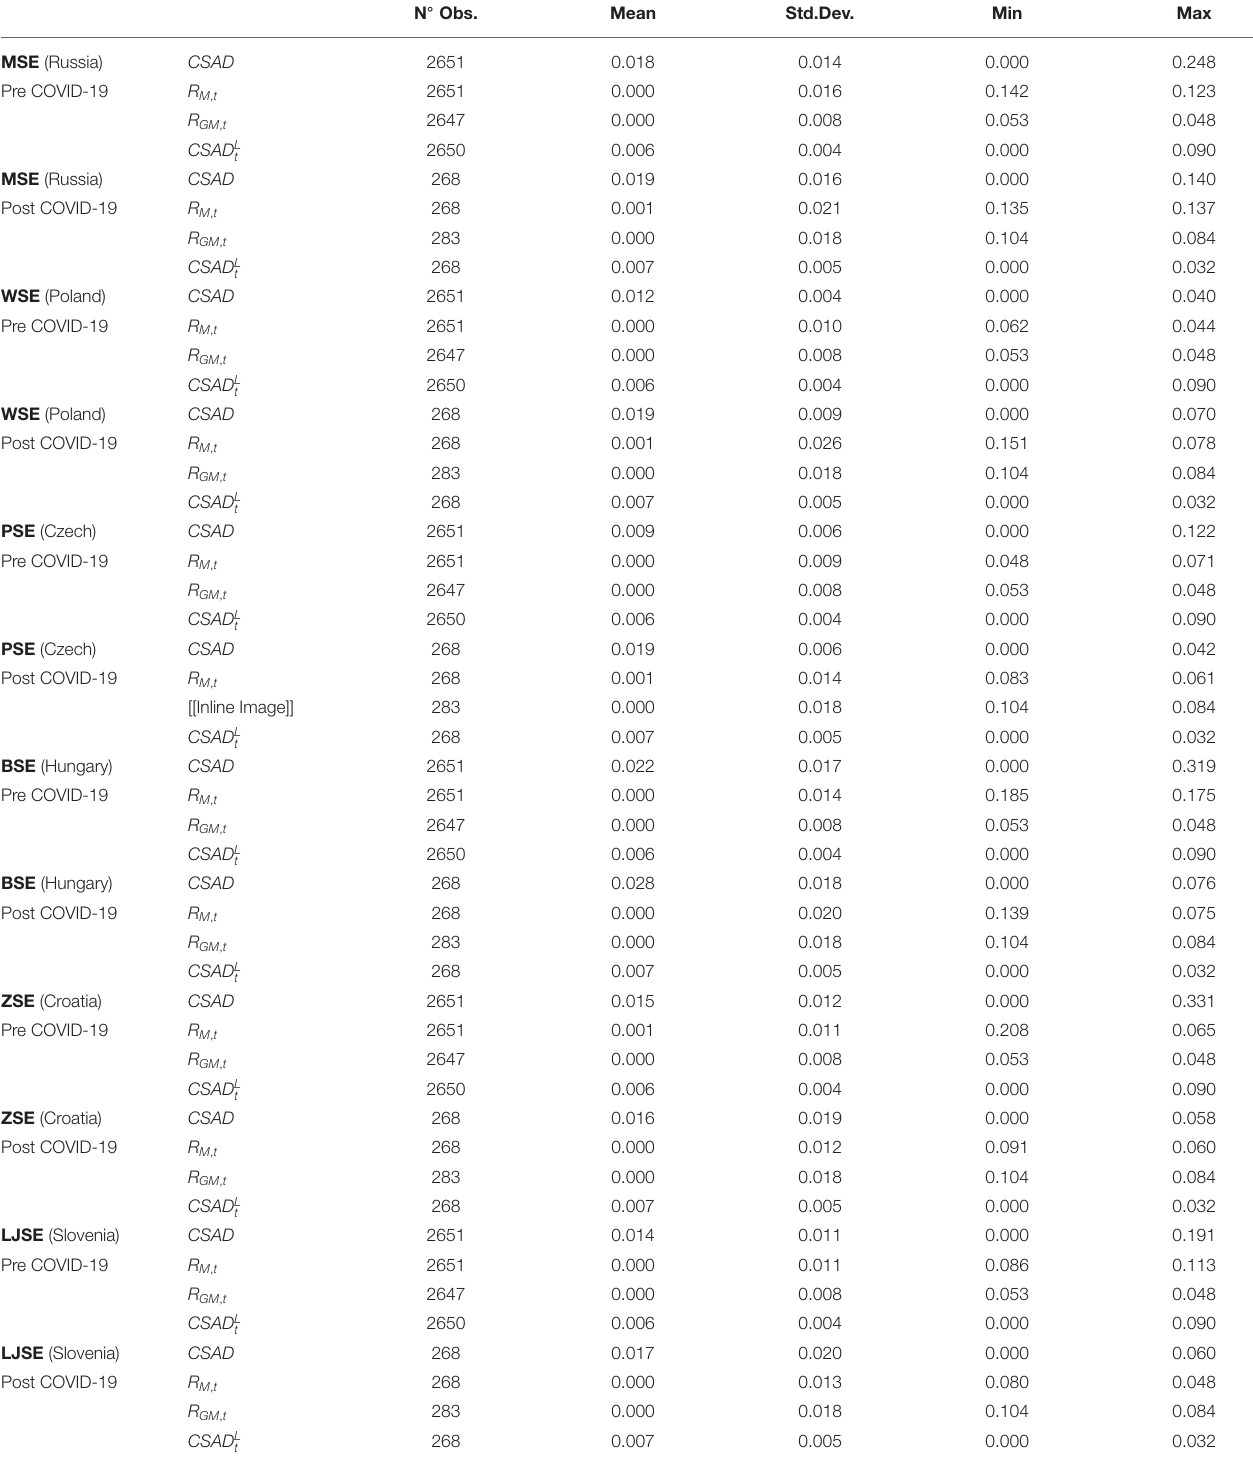
TABLE 2 | Descriptive